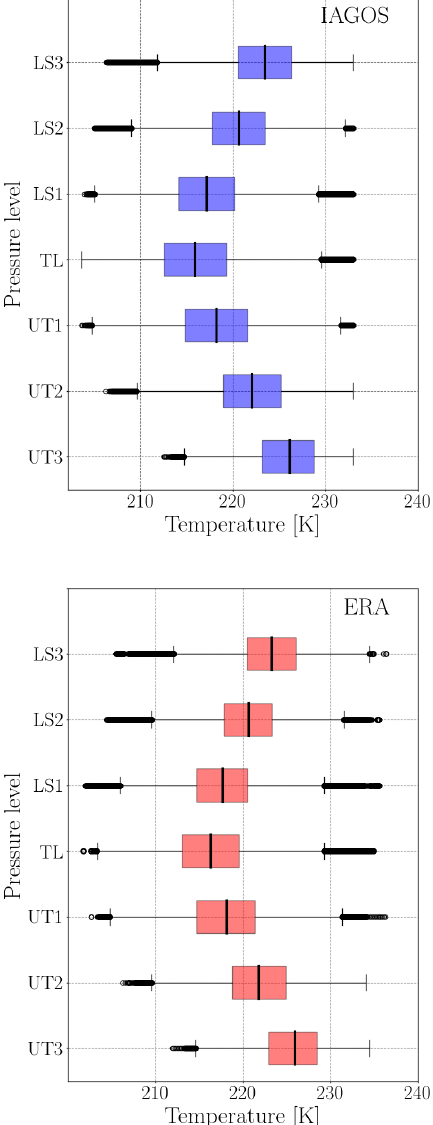
Figure 3. Vertical profile of H 2 O volume mixing ratio (ppmv) for IAGOS (blue) and ERA